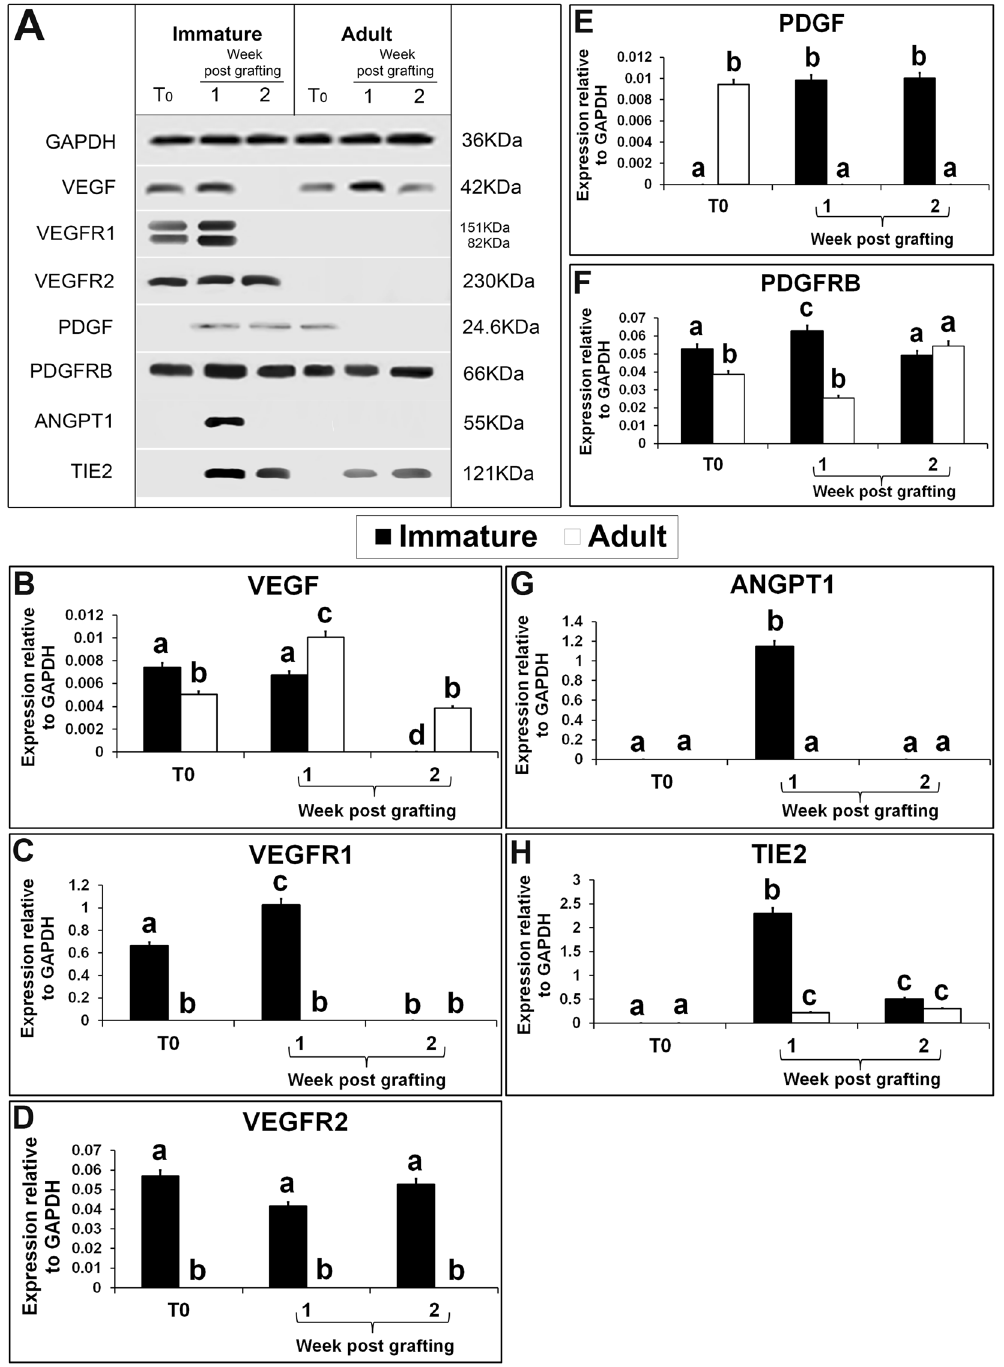
Figure 3. Western blot analysis of xenografted immature and adult testes at 1-and 2-wk-post grafting for expression of growth factors and their receptor-specific proteins. Protein expression in 6-day-old and 10-wk-old donor testes before grafting (T0) are presented as starting material. Representative blot ( A ) and densitometry analysis of ( B ) VEGF, ( C ) VEGFR1, ( D ) VEGFR2, ( E ) PDGF, ( F ) PDGFRB, ( G ) ANGPT1, and ( H ) TIE2 protein. Y-axis represents intensity of bands relative to GAPDH. Data are presented as mean ± SEM. Bars with different letters are significantly different at P <